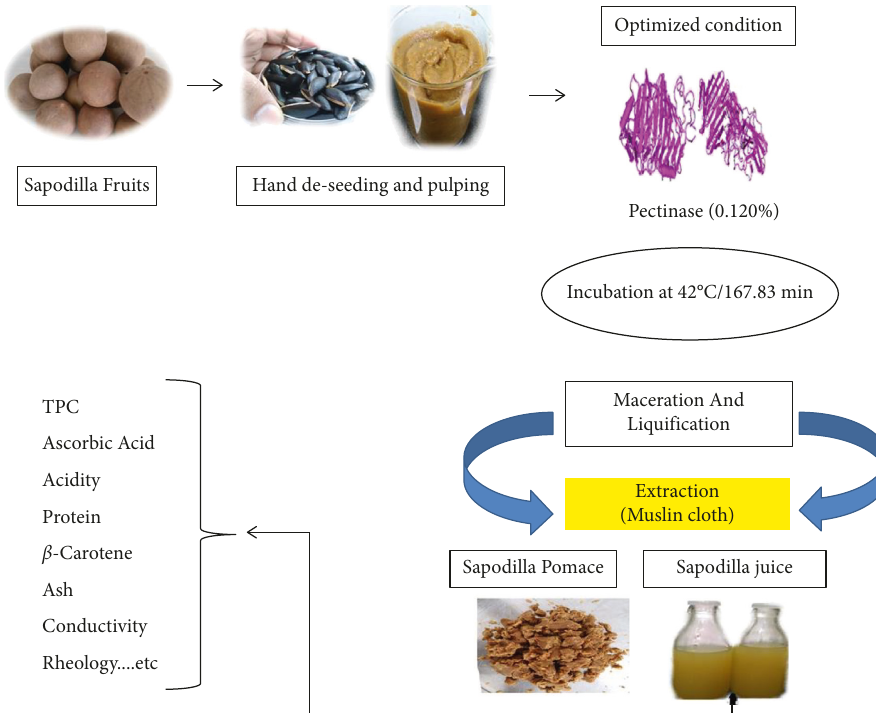
Figure 1: Experimental flow diagram adapted for the processing of sapodilla